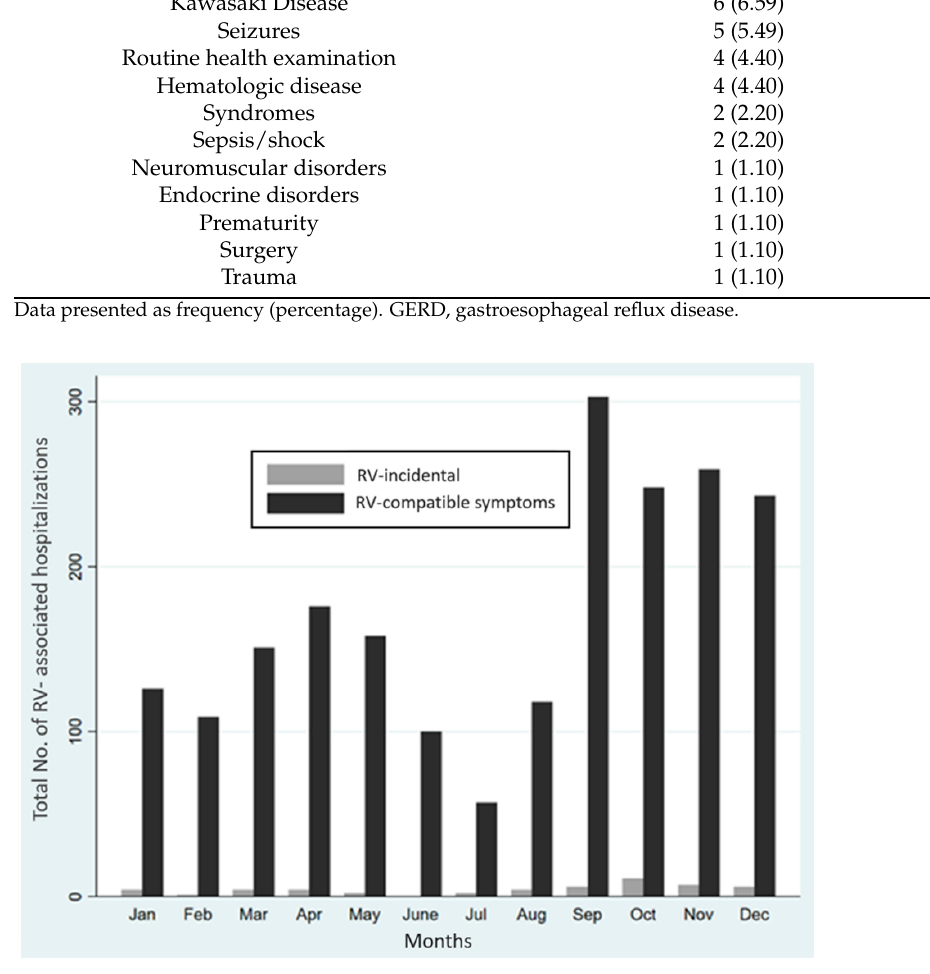
Figure 2. Seasonality of RV-associated hospitalizations. The horizontal axis shows the months of the year for RV detection in patients with compatible (black) symptoms and RV incidental detection. The vertical axis shows the total number of RV-associated hospitalizations in both